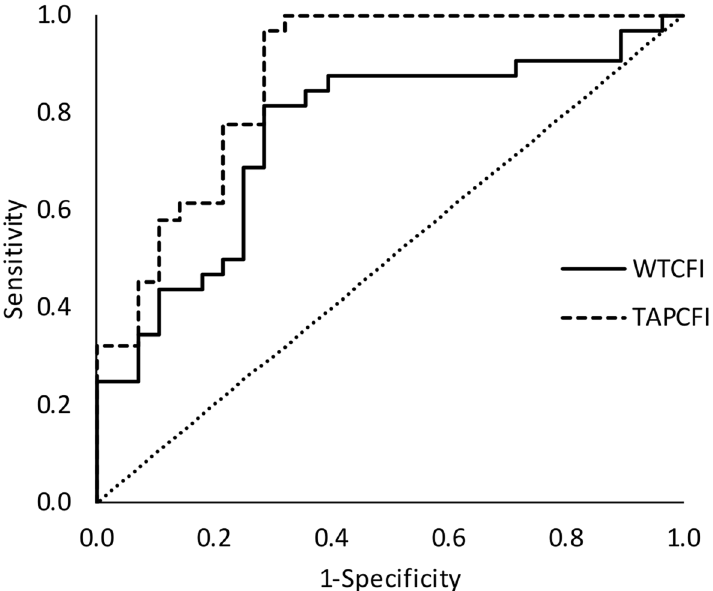
Figure 4. ROC Curves for SDB classification for severe (n: 28) and mild (n: 31) SDB patients according to TAP robustness (TAPCFI, discontinuous line) versus to wrist temperature robustness (WTCFI, continuous